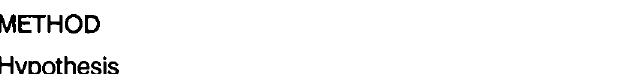
TABLE 1: PRE-EXERCISE SPIROMETRY Asthma